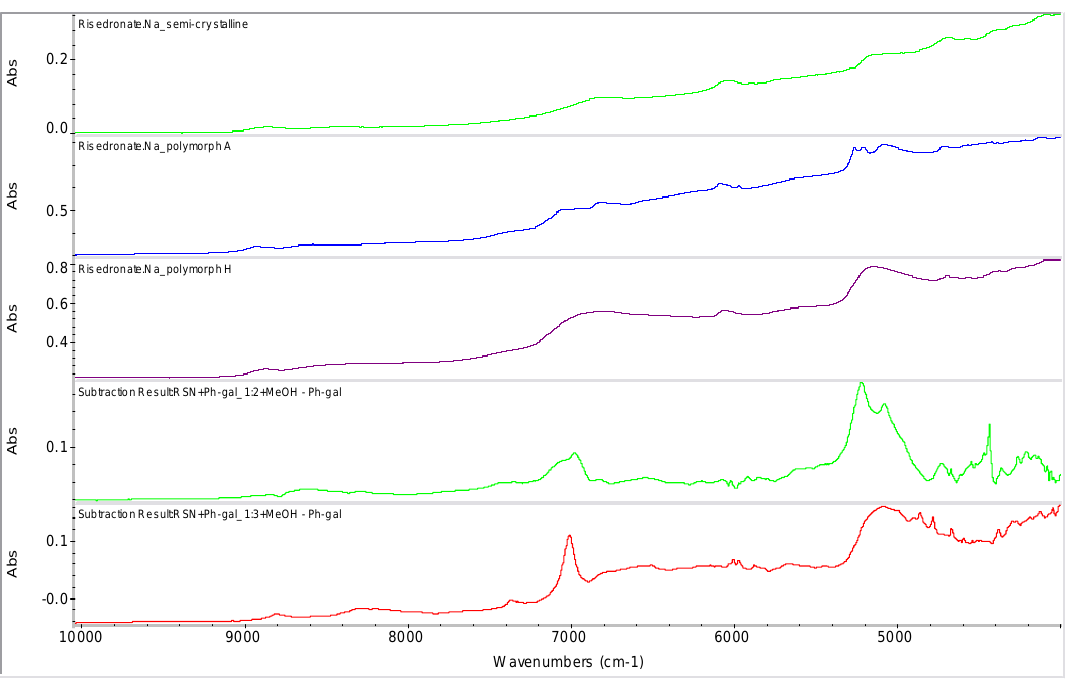
Figure 14. FT-Raman spectra of semi-crystalline risedronate monosodium salt (RSN), forms A and H, phenyl- β - D -galactopyranoside (Ph-gal) and samples 6 and 7